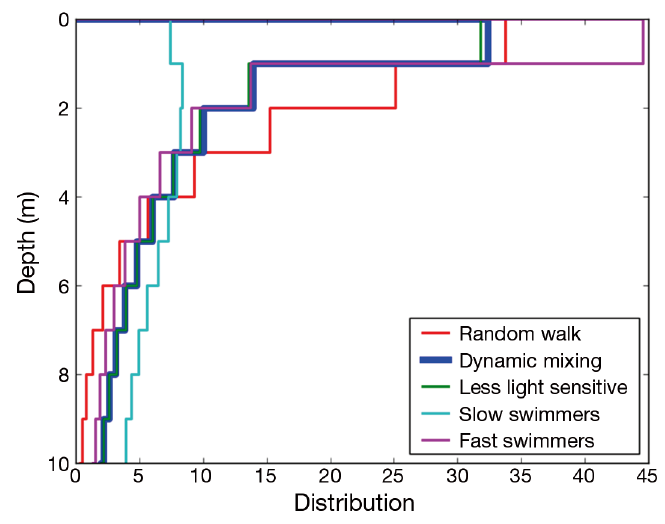
Fig. 5. Aggregated vertical distribution of salmon lice Lepeoph- theirus salmonis copepodids during simulations from all farms with parameters as defined in Table 1